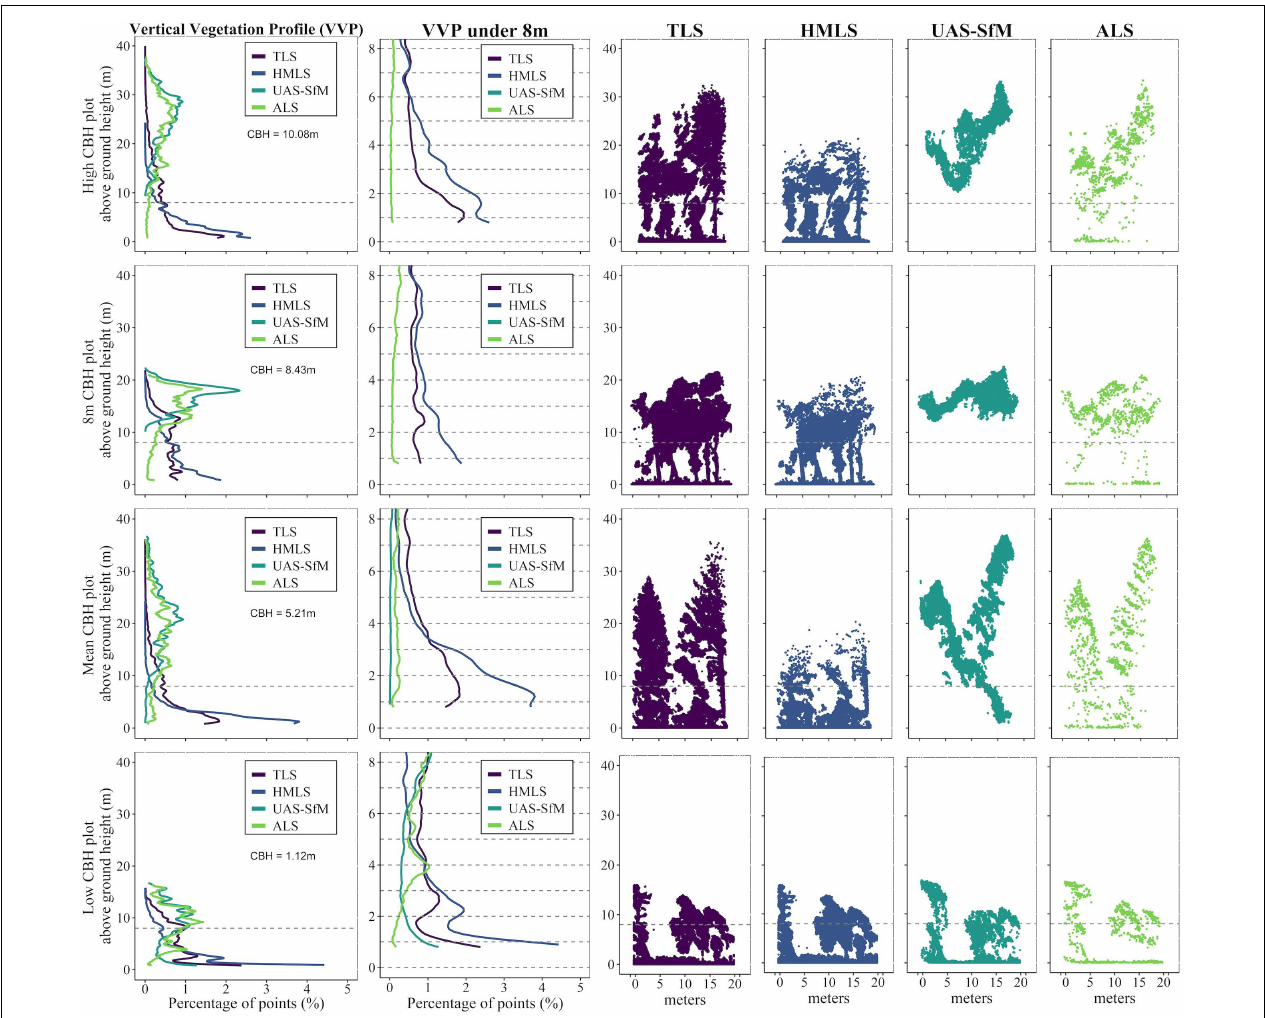
FIGURE 2 | Vertical profile of vegetation (VVP) generated by each remote sensing method, separated into bins based on CBH for a representative plot. The CBH categories used are as follows: low (0–3 m), medium (3.01–6 m), high (6.01–9 m), and very high ( > 9 m). We included a plot with a CBH of ∼ 8 m as this is the mean plus one standard deviation and used as the maximum height for our ladder fuels strata. The percentage of points at each height was found by dividing the number of points at each height by the total number of points (above 0.5 m) for each method. VVP under 8 m shows the same data as the whole VVP, but zoomed in. The gray dashed line shown in the VVP represents 8 m, the maximum height we used for ladder fuels, the gray dashed lines shown in the VVP under 8 m, are in 1m increments and represent our ladder fuel densities.